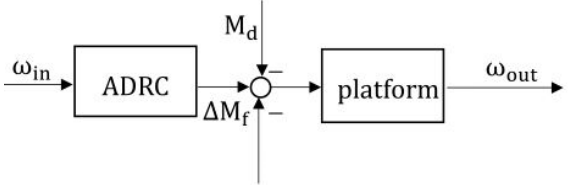
Figure 5. Block diagram of system disturbance after friction